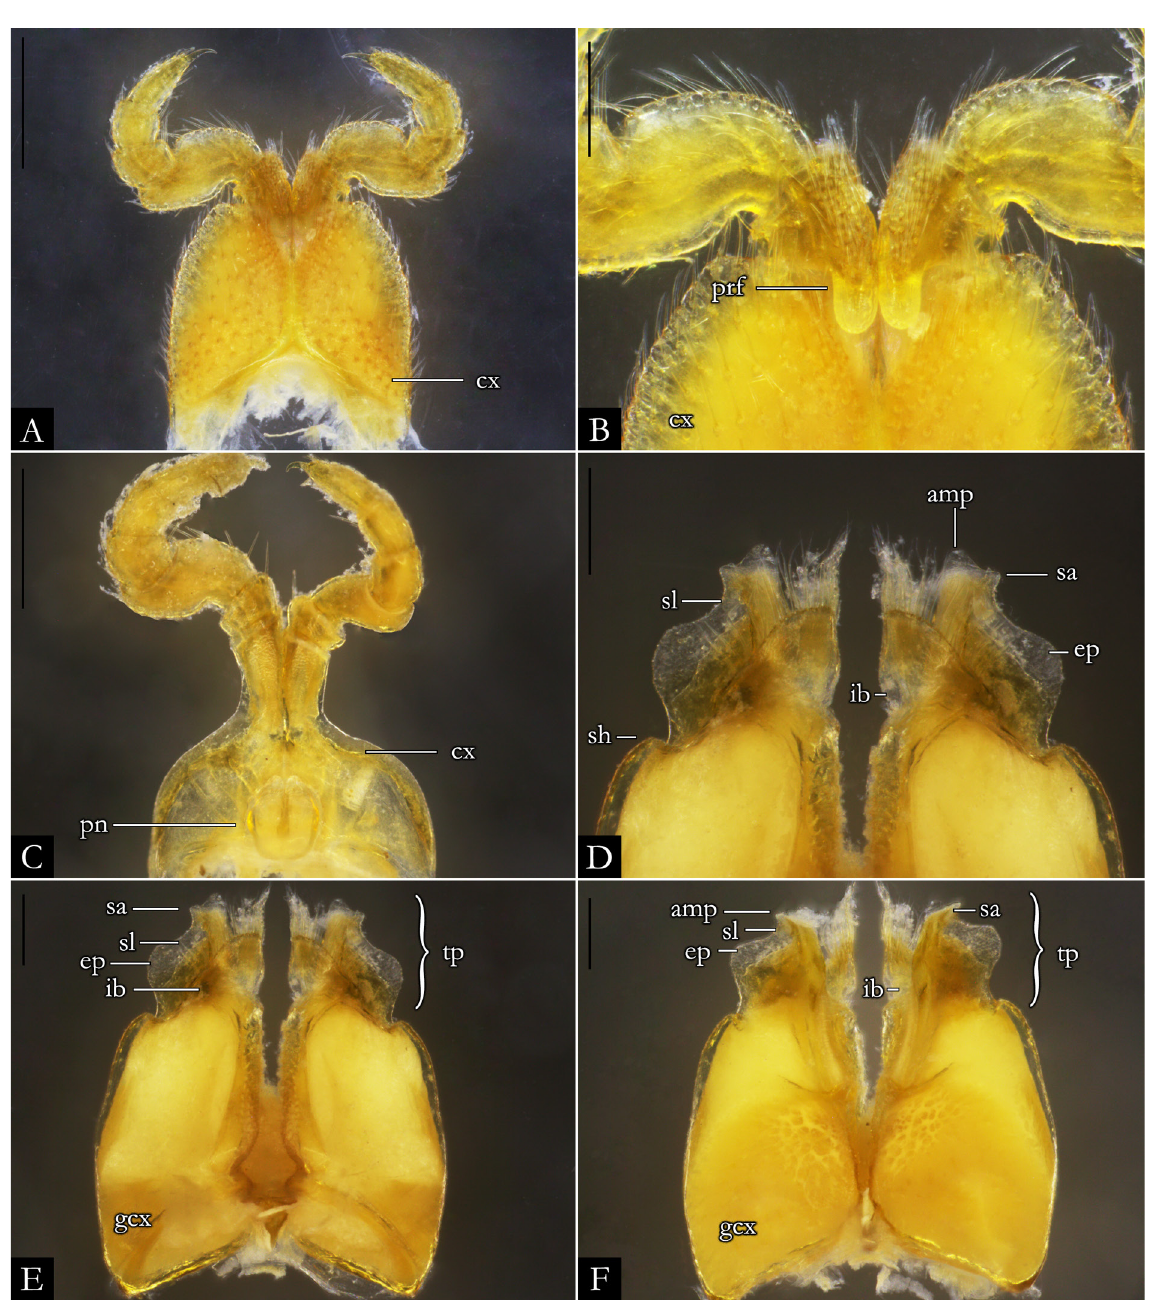
Fig. 42. Pseudonannolene albiventris Schubart, 1952, ♂ (MZSP 1007). A . First leg-pair. B . Detail of prefemur. C . Second leg-pair. D . Detail of telopodites, in anal view. E . Gonopods, in anal view. F . Gonopods, in oral view. Abbreviations: see Material and methods. Scale bars: A, C = 0.5 mm; B, D–F = 0.2